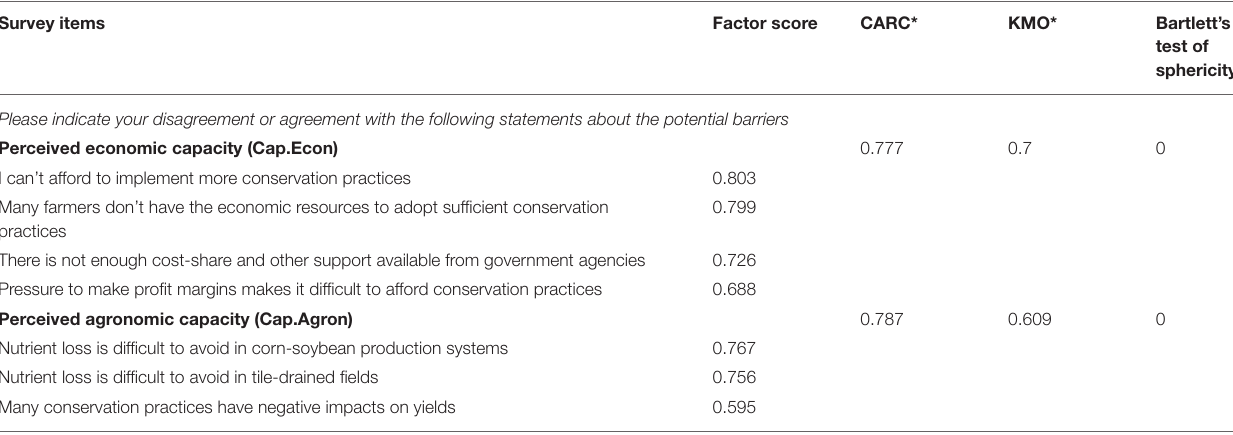
TABLE 2 | Factor scores and reliability tests for farmers’ economic and agronomic capacity to implement different water quality improvement practices in Iowa. Survey items